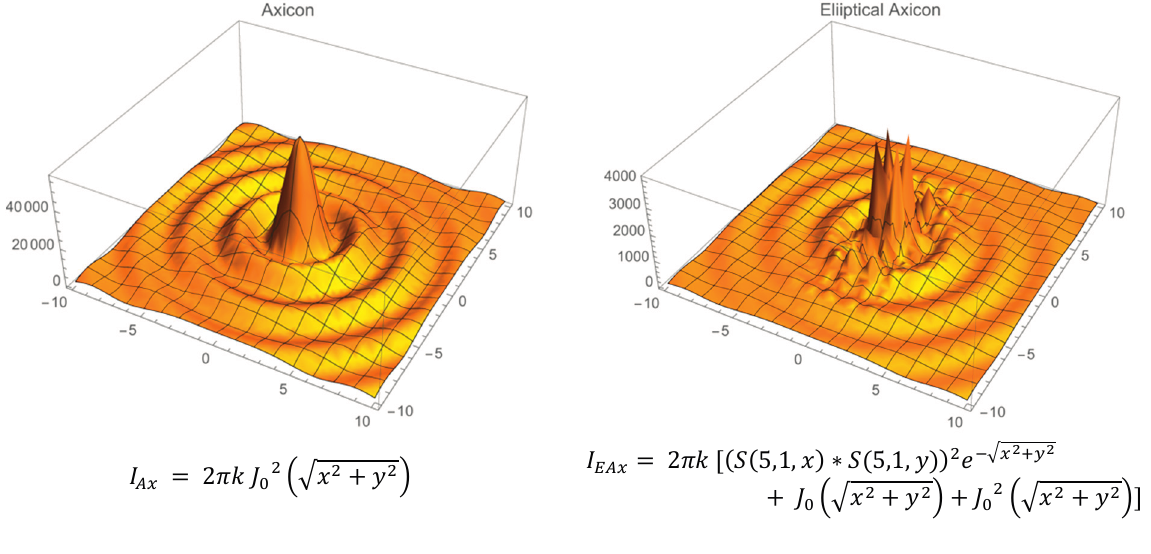
Figure 7. Equations to simulate intensity profiles for regular and elliptical axicon intensity profiles at a particular axial distance Z ≤ focal length [23,24]. The function S is the Mathieu sine function, and k is the angular